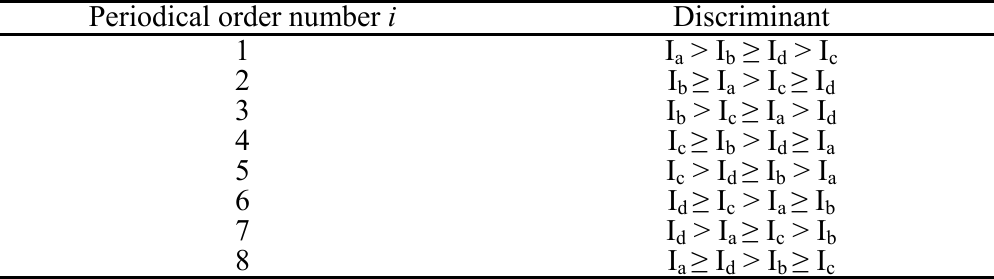
Table 1. The discriminant of periodical